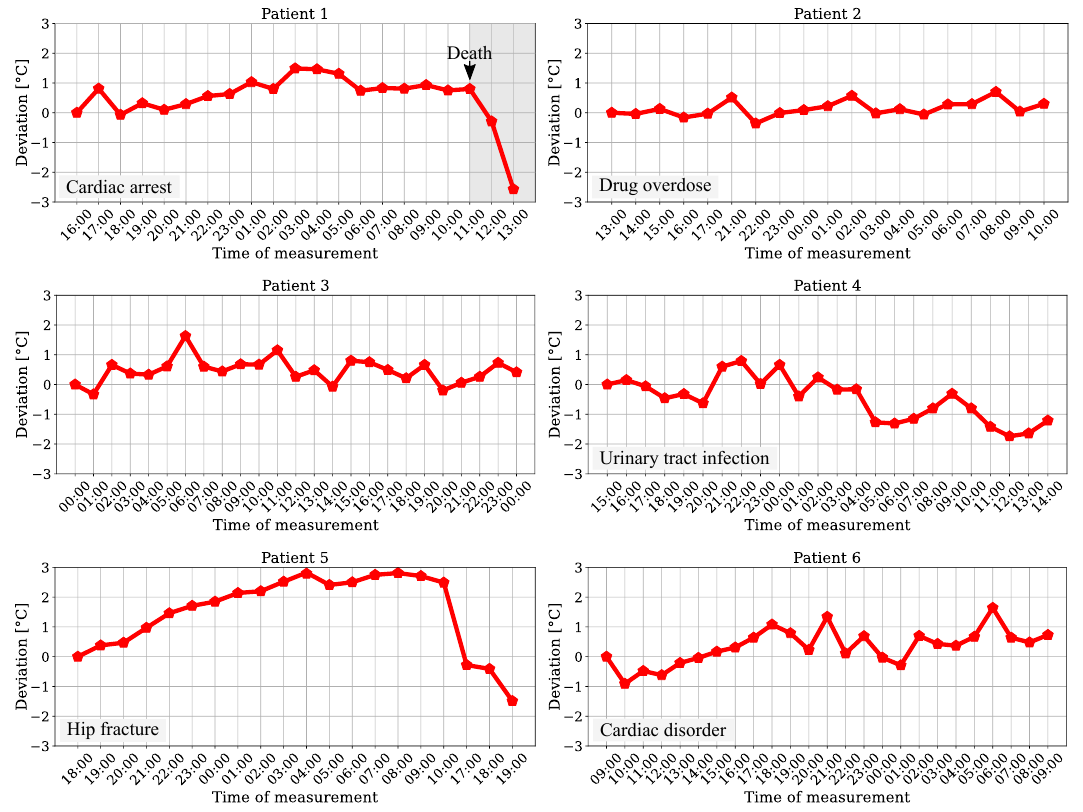
Figure 12. Head surface temperature deviation for patients from the test